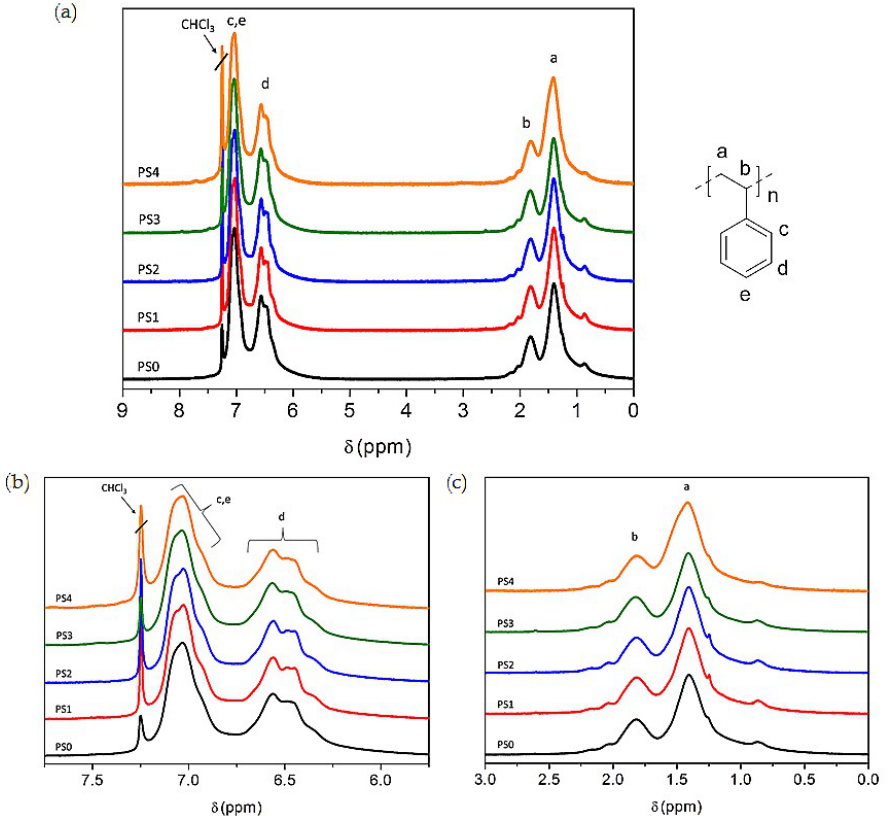
Figure 4. Stacked 1 H-NMR spectra results of the PS0 (original) sample and PS1–4 (thermally treated) samples. Labels, a–e, represent the positions of hydrogen atoms as shown on the PS diagram featured. Graph ( a ) shows the overall spectra; ( b ) displays 7.5–6.0 ppm; ( c ) details 3.0–0.5 ppm.